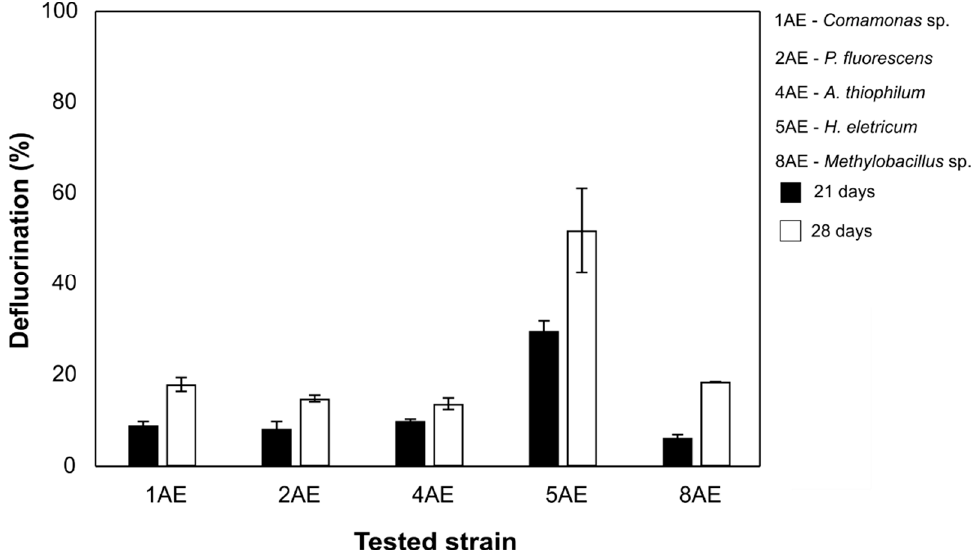
Figure 3. Defluorination percentage of each bacterial strain isolated from the EPO-enriched consortium, after 21 and 28 days. Results are expressed as the mean of duplicates and bars represent the error.